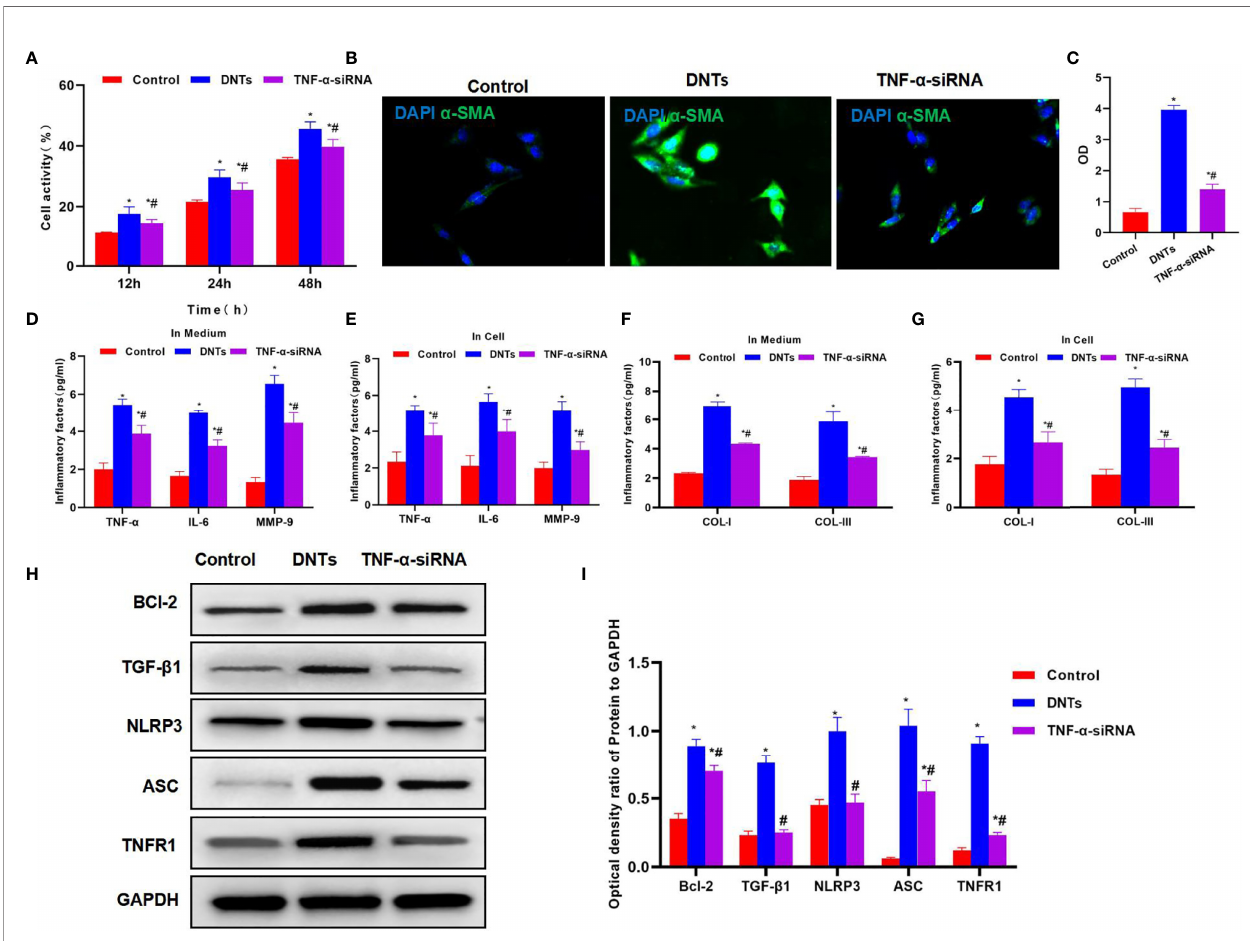
FIGURE 5 | Effect of DNTs on HSC activation after TNF- a silencing (TNF- a siRNA). (A) After TNF- a silencing, DNTs had reduced ability to increase HSC viability, and cell viability markedly decreased compared with DNT group. *p < 0.05 compared with control group, # p < 0.05 compared with DNT-HSC group. (B, C) Fluorescence intensity of HSC activation marker a -SMA signi fi cantly decreased in TNF- a siRNA. *p < 0.05 compared with control group, # p < 0.05 compared with DNT-HSC group. (D, E) Expression results of in fl ammatory factors suggested that the in fl ammatory factor levels in TNF- a siRNA signi fi cantly decreased, lower than those in DNT group. *p < 0.05 compared with control group, # p < 0.05 compared with DNT-HSC group. (F, G) After TNF- a silencing, DNTs had reduced ability to induce collagen expression in HSCs. The levels of COL-I and COL-III signi fi cantly decreased in TNF- a siRNA, which were lower than those of DNT group. *p < 0.05 compared with control group, # p < 0.05 compared with DNT-HSC group. (H, I) After TNF- a silencing, DNTs had decreased ability to induce TNFR1 and Bcl-2 expression, and protein levels were markedly lower than those in DNT group. *p < 0.05 compared with control group, # p < 0.05 compared with DNT-HSC group. DNTs, double-negative T cells; HSC, hepatic stellate